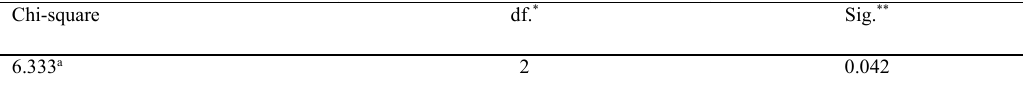
Table 6: Considering Chi-square